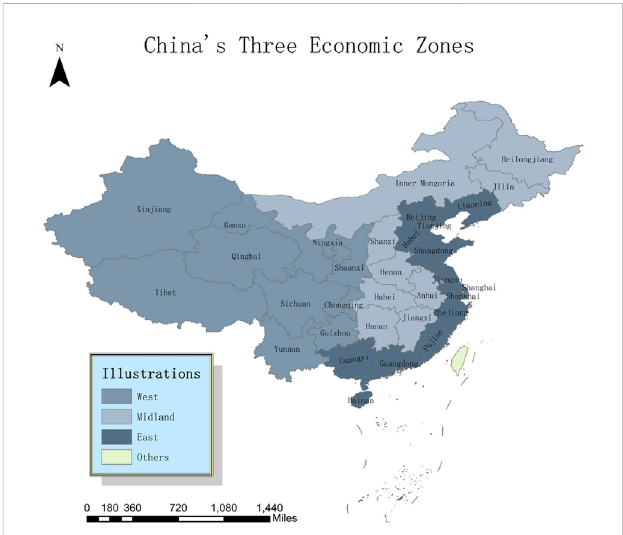
FIGURE1 GeographicalmapofChinaaccordingtothethreemajoreconomic zones of the study